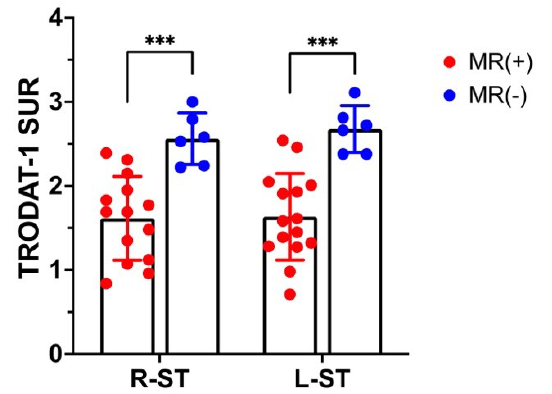
Figure 2. Dopamine transporter (DAT) availability (SURs) and MR findings in the right and left striata. Necrosis of the globus pallidus (GP) on MR images; patients were classified as GP positive (GP+) or GP negative (GP − ). The GP+ patients had significantly lower DAT availability on both sides of the striatum compared to GP-patients. Data are mean ± SD; *** p < 0.005. Overall, 68% (13/19) of the subjects with DNS were diagnosed with Parkinsonian syndrome and 32% (6/19) were diagnosed with non-Parkinsonian syndrome; two subjects were not examined for Parkinsonian syndrome. Male patients with DNS had a higher in- cidence of Parkinsonian syndrome than female patients. Additionally, all male and female GP(+) DNS patients were diagnosed with Parkinsonian syndrome. However, there were no significant differences in the clinical findings between sexes. The MR imaging of the globus pallidus (GP) in patients with Parkinsonism are summarized in Table 2. Table 2. Association of MR imaging features in the globus pallidus (GP) with diagnosis of Parkin- sonism .